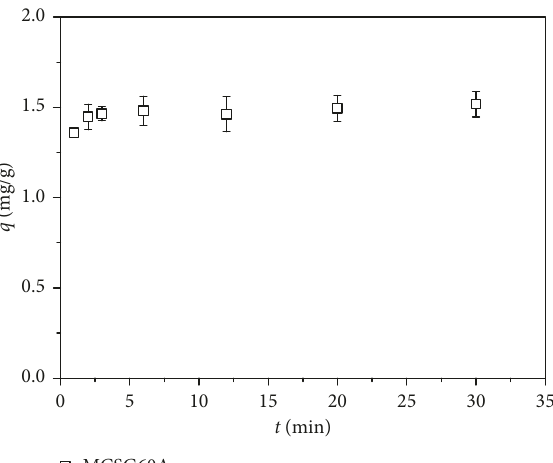
12.5g/L, pH 6, (cid:30) (cid:30)